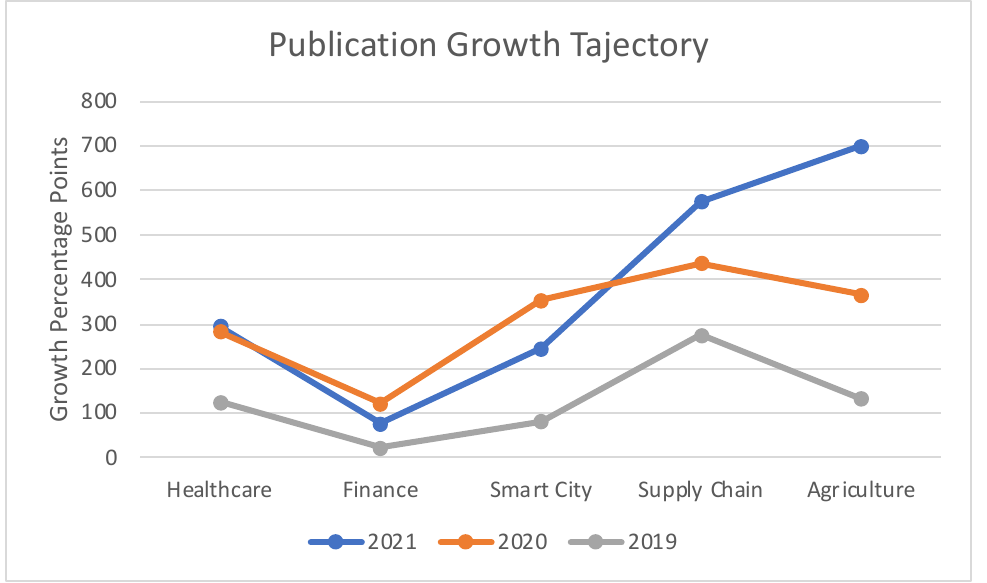
Figure 21. Comparison of Publication Growth Trajectory among Blockchain Application Areas.